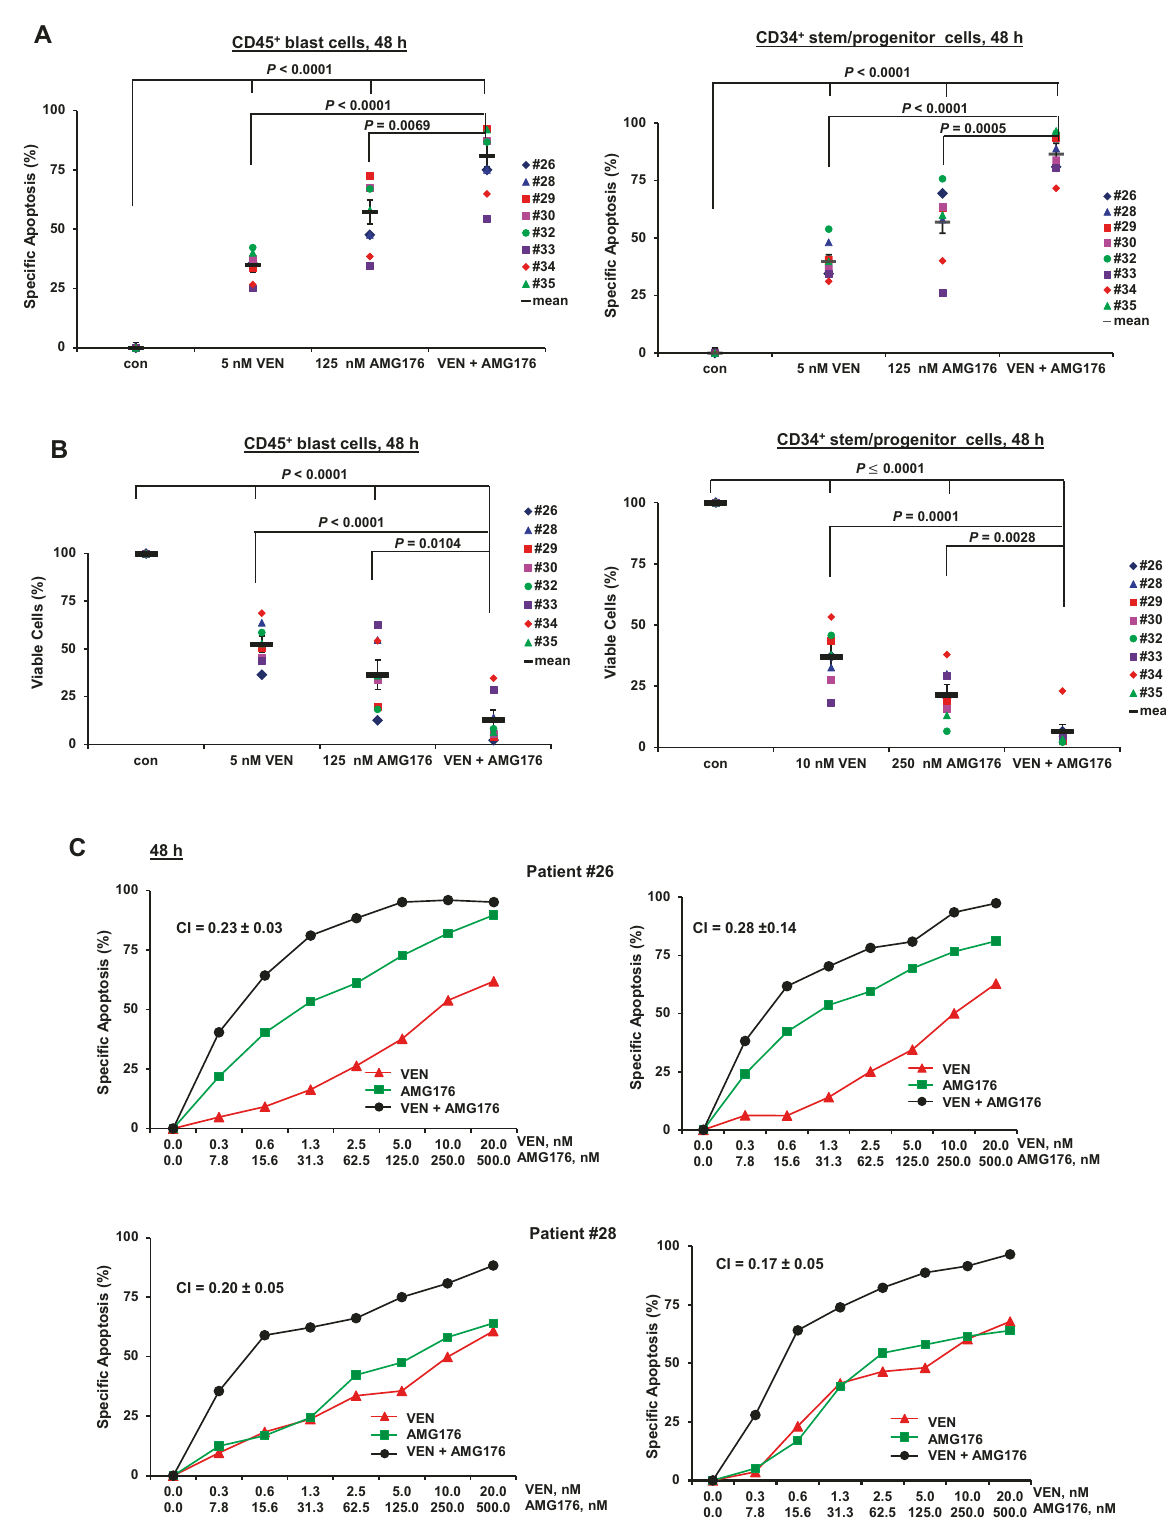
Fig. 5 The combined inhibition of BCL-2 and MCL-1 is signi fi cantly more effective in AML cells and AML stem/progenitor cells from patients with TP53 mutations. A , B AML patient samples ( n = 8) with TP53 mutations were treated with VEN, AMG176, or both for 48 h. Apoptosis ( A ) and viable cells ( B ) were determined by fl ow cytometry. h hour. Error bars represent mean ± SEM of data from individual patients. C AML patient samples ( n = 8) with TP53 mutations were treated with various concentrations of VEN, AMG176, or both for 48 h. Apoptosis and the CI values from two representative patient samples (#26, #28) are shown. Cell death is expressed as speci fi c apoptosis and viable cells are expressed as % compared to the control of 100%. con